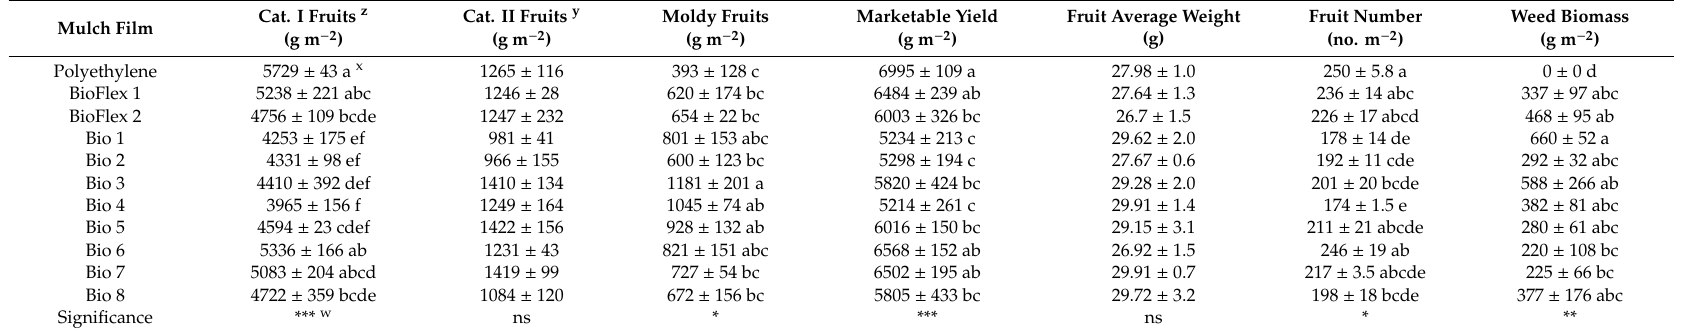
Table 2. E ff ects of di ff erent mulch films on strawberry yield, yield components, and weed biomass of strawberry.